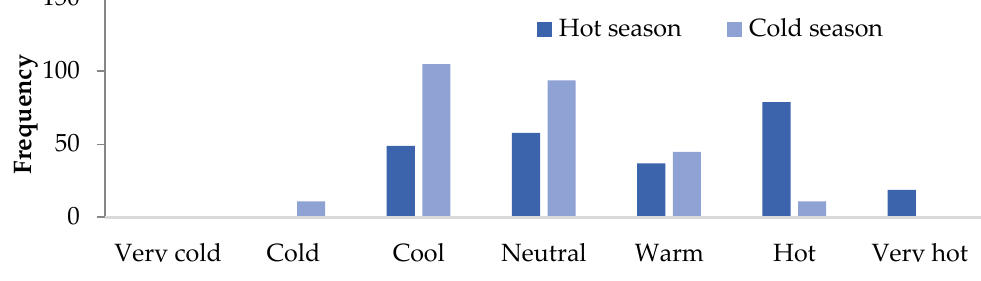
Figure 4. TSV frequency statistics.